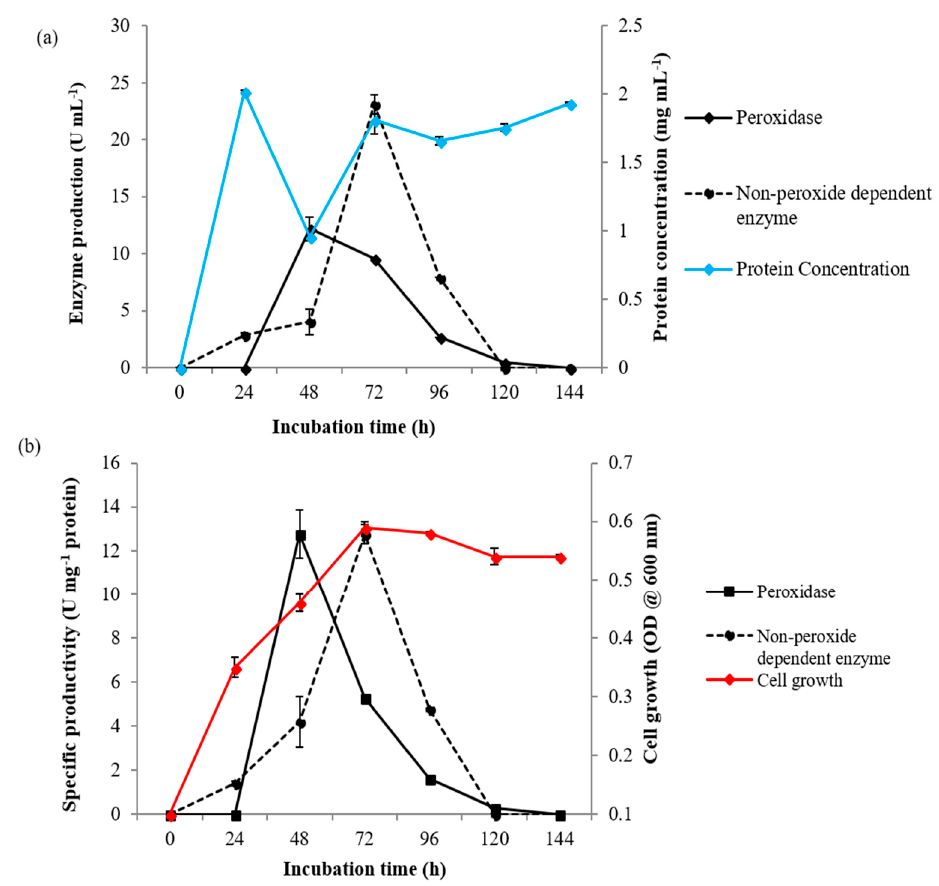
Figure 3. Exoperoxidase production by Ensifer adhaerens NWODO-2 over a time course. ( a ) Enzyme production and protein concentration. ( b ) Specific productivity and cell growth.